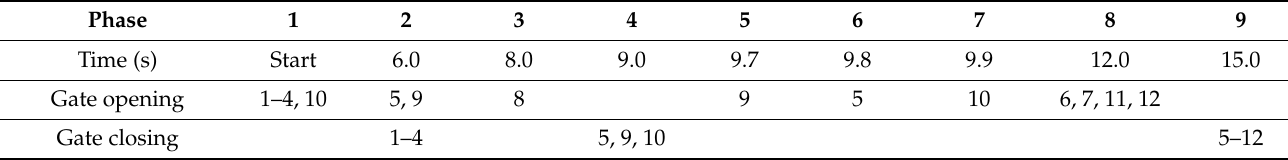
Table 2. Preset sequence of the filling valve